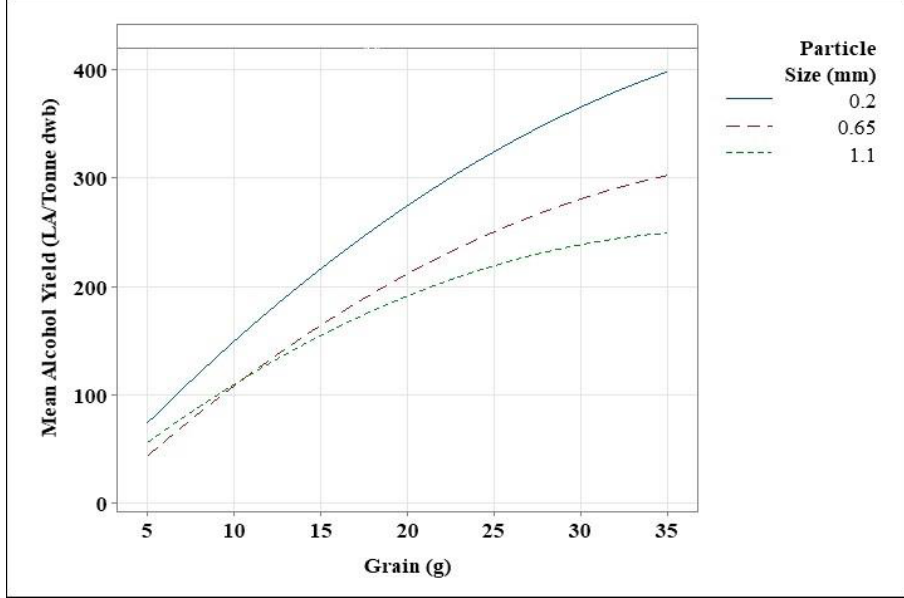
Figure 6. Interaction plots display the effect that both grain amount and grain particle size have on alcohol during the response surface model. This graph shows that a grain particle size of 0.2 mm at 35 g of grain will produce the highest